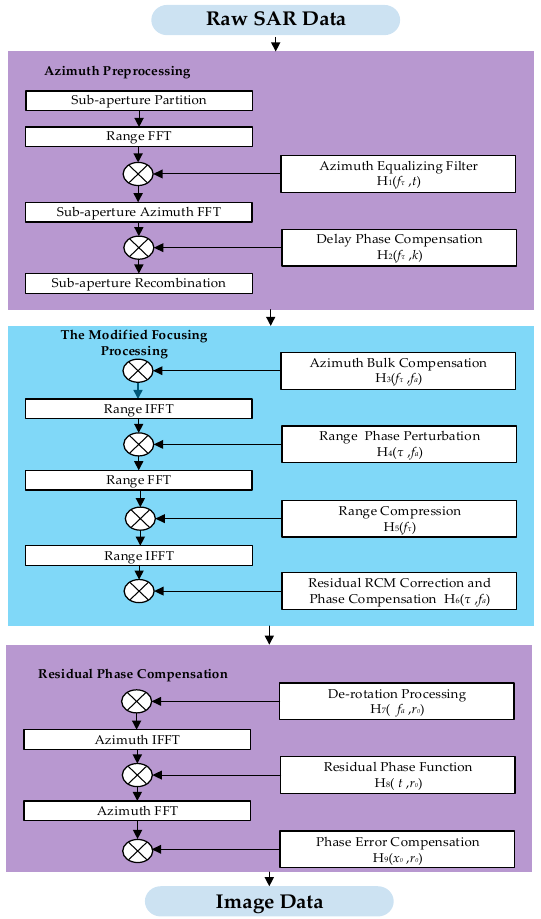
Figure 6. Block diagram of the MHCA based on the SV-ESRM.